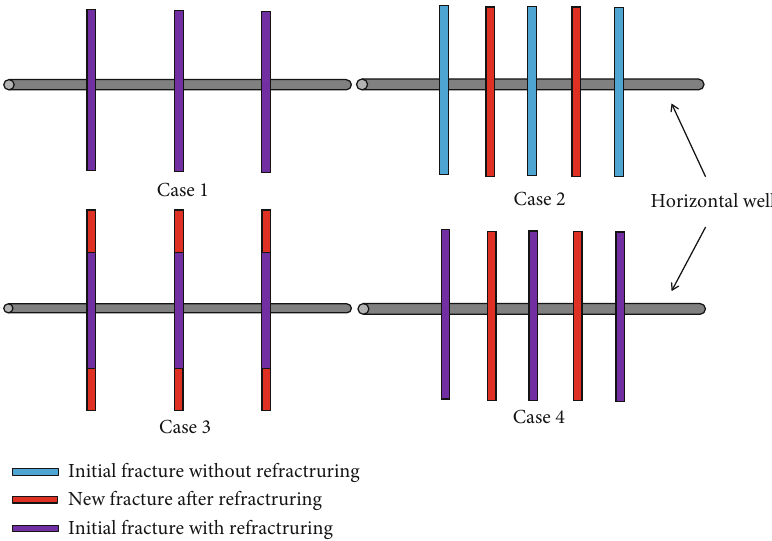
Figure 10: Schematic diagram corresponding to di ff erent refracturing scenarios.